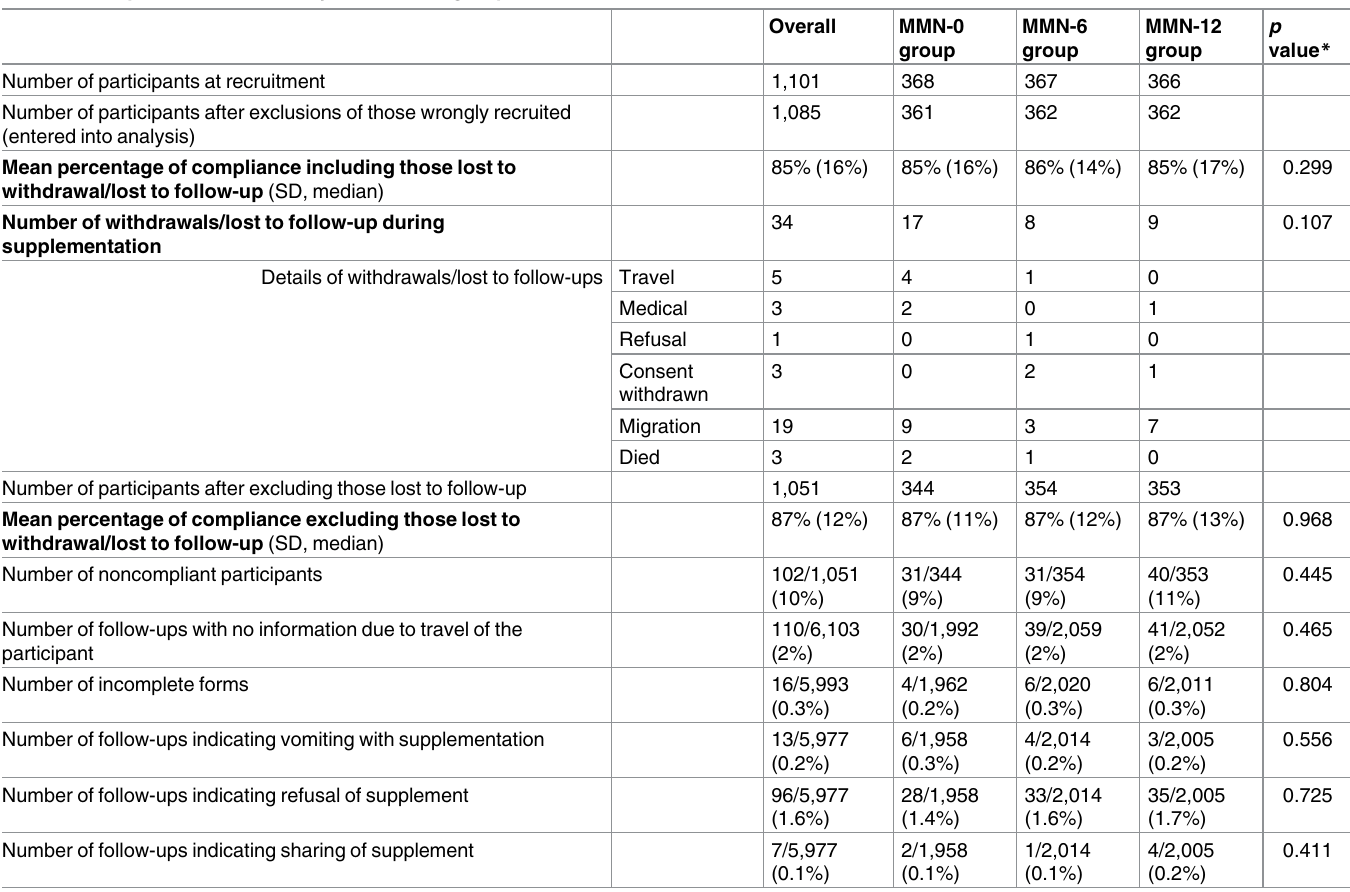
Table 2. Compliance overall and by intervention